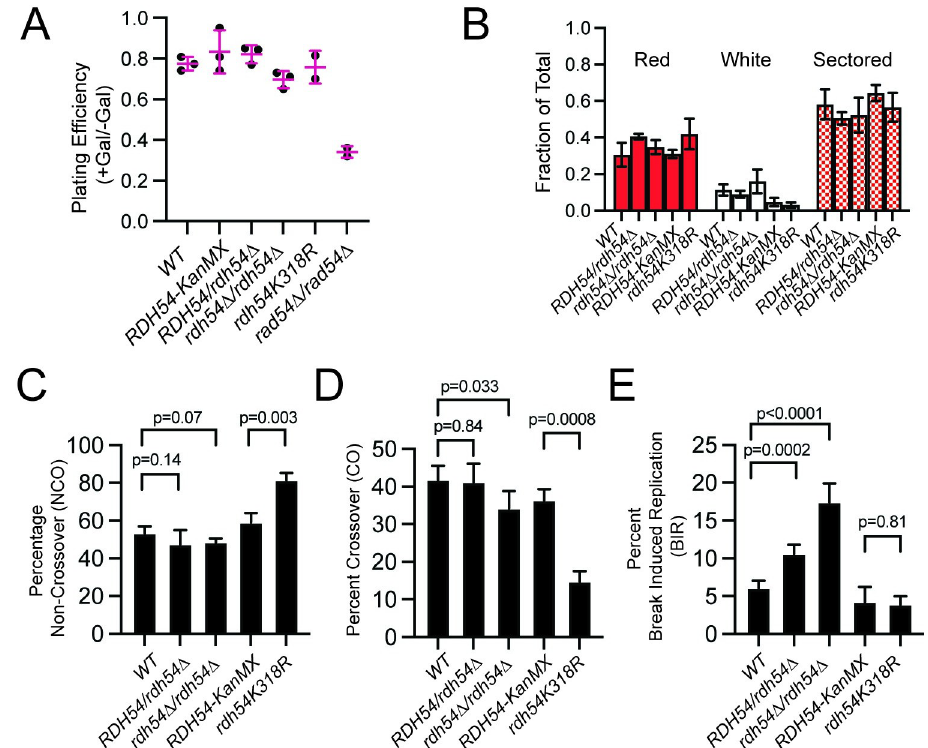
Fig 2. Loss of RDH54 results in an increase in BIR outcomes. (A). Graph representing the plating efficiency of WT, RDH54-KanMX/RDH54-KanMX , RDH54/rdh54 Δ , rdh54 Δ /rdh54 Δ , rdh54K318R/rdh54K318R , and rad54 Δ /rad54 Δ . Crossbar and error bars represent the mean and standard deviation of independent measurements. (B). Graphical representation of the fraction of cells that are red, white, or sectored after DNA double strand break repair. Strains represented here are WT , RDH54/rdh54 Δ , rdh54 Δ /rdh54 Δ , RDH54-KanMX/RDH54-KanMX , rdh54K318R/ rdh54K318R . The column and the error bars represent the mean and standard deviation of at least three independent experiments. (C). Graph representing the percentage of non-crossover outcomes for WT, RDH54-KanMX/ RDH54-KanMX , RDH54/rdh54 Δ , rdh54 Δ /rdh54 Δ , rdh54K318R/rdh54K318R . Measurements represent the mean and standard deviation of four independent experiments. (D). Graph representing the percentage of crossover outcomes for WT, RDH54-KanMX/RDH54-KanMX , RDH54/rdh54 Δ , rdh54 Δ /rdh54 Δ , rdh54K318R/rdh54K318R . Measurements represent the mean and standard deviation of four independent experiments. (E). Graph representing the percentage of Break induced replication (BIR) outcomes for WT, RDH54-KanMX/RDH54-KanMX , RDH54/rdh54 Δ , rdh54 Δ / rdh54 Δ , rdh54K318R/rdh54K318R . Measurements represent the mean and standard deviation of at least four independent